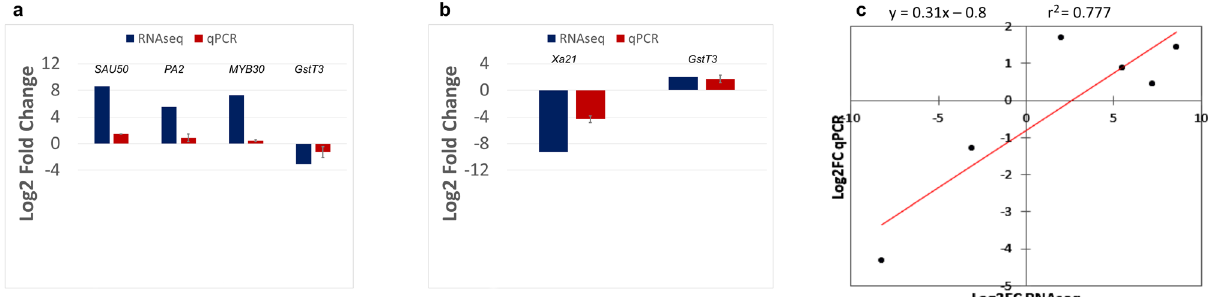
Figure 8. Validation of RNASeq data with qPCR. ( a ) and ( b ) Expression of five randomly selected genes was examined by qPCR analysis. For each gene, fold changes were calculated by ΔΔCt method and log2Fold change were compared between qPCR and RNAseq. ( c ) Correlation between RNAseq and qPCR data based on log2fold change of the five selected genes: y = 0.31x –